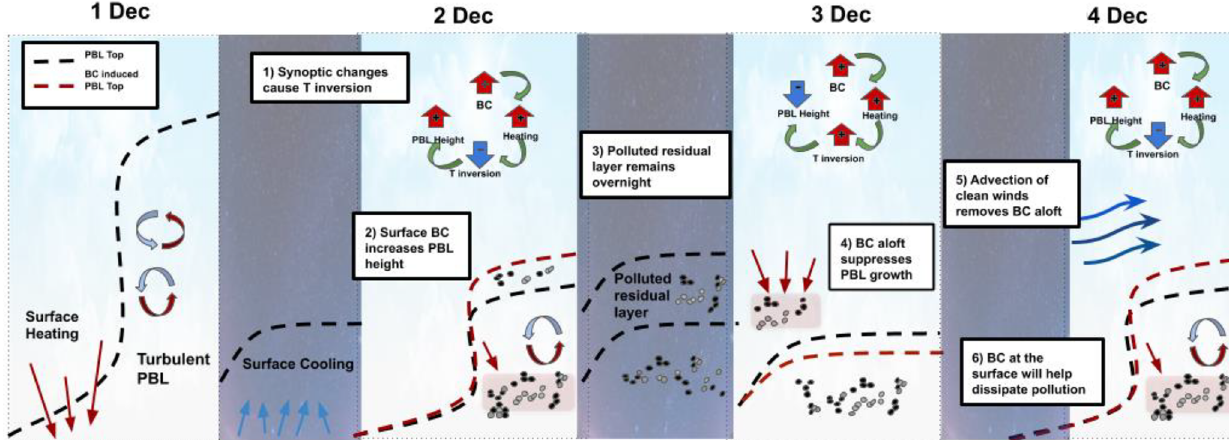
Figure 11. Schematic to show the potential impact of BC on a Beijing haze episode which occurred between 1 and 4 December 2016, where both the onset and dissipation of the pollution episode are brought about by changing synoptic patterns. The dashed black lines indicate PBL top, with the dashed red lines indicating the change caused by BC interactions and the type of impact that is dependent on the altitude of the BC